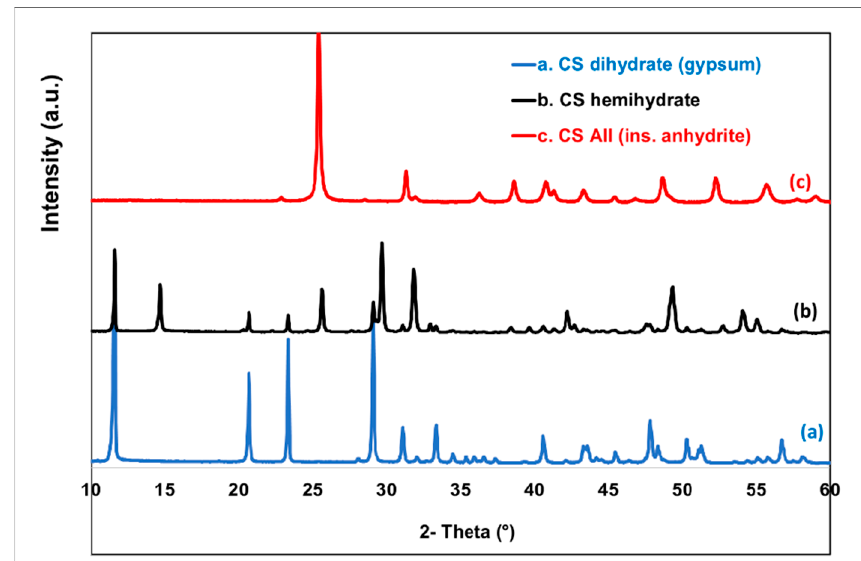
Figure 6. XRD patterns of CS AII and of CS hydrated forms.